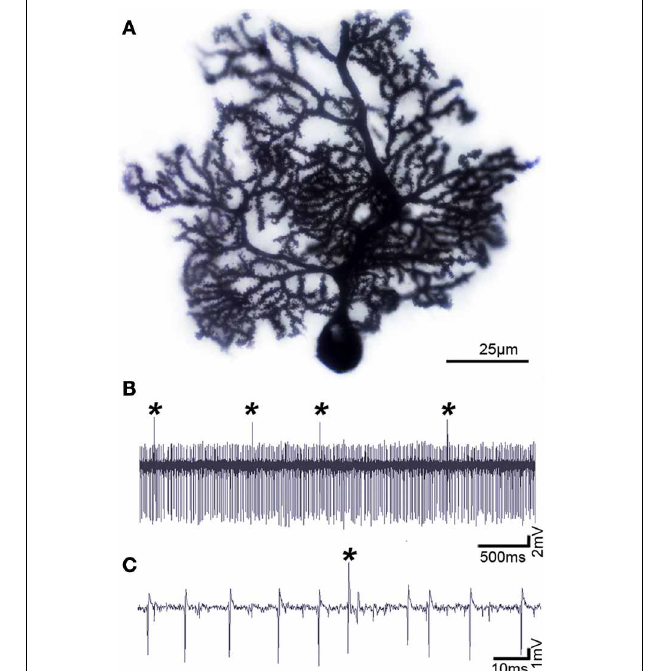
1982) and olivo-cortico-nuclear loops (Angaut and Sotelo, 1987;